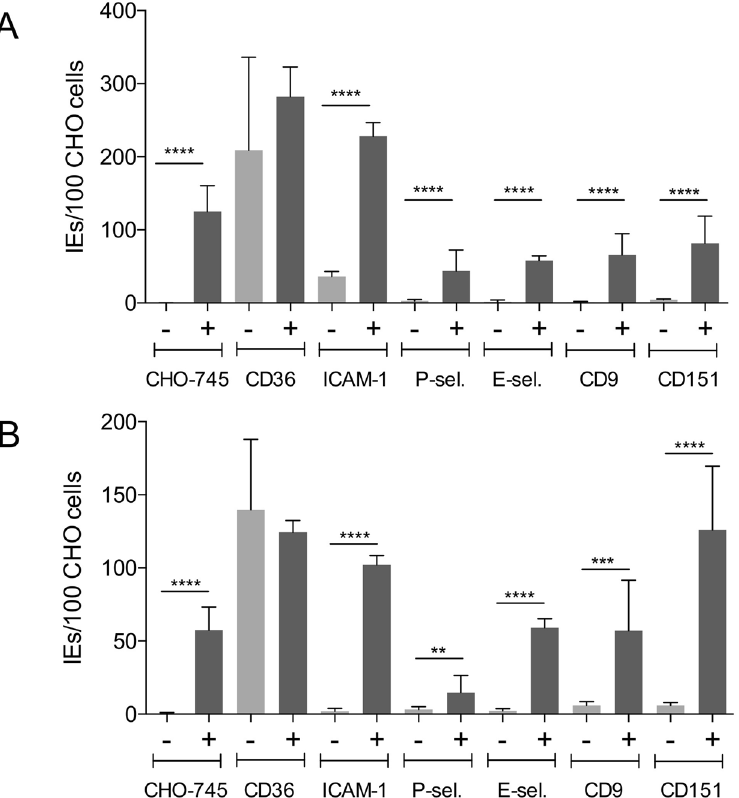
Figure 1. The binding capacity of P. falciparum isolates IT4 and 3D7 to wild type CHO-745 cells and to various endothelial receptors before ( − ) and after ( + ) enrichment for binding to a receptor of interest. CHO-745 cells expressing the receptor of interest on their surface were used to analyse the binding capacity of isolates IT4 ( A ) and 3D7 ( B ). After incubation of trophozoite-stage IEs with the respective CHO-745 cell monolayer seeded on a coverslip, the slides were washed, fixed with 1% glutaraldehyde and finally stained with Giemsa stain. Bars represent the mean number ± SD of IEs that bound per 100 CHO-745 cells, as determined by light microscopic evaluation. CHO-745, non-transfected CHO-745 WT cells. Statistical significance was determined using the unpaired t -test; ** p < 0.01, *** p < 0.001, **** p <